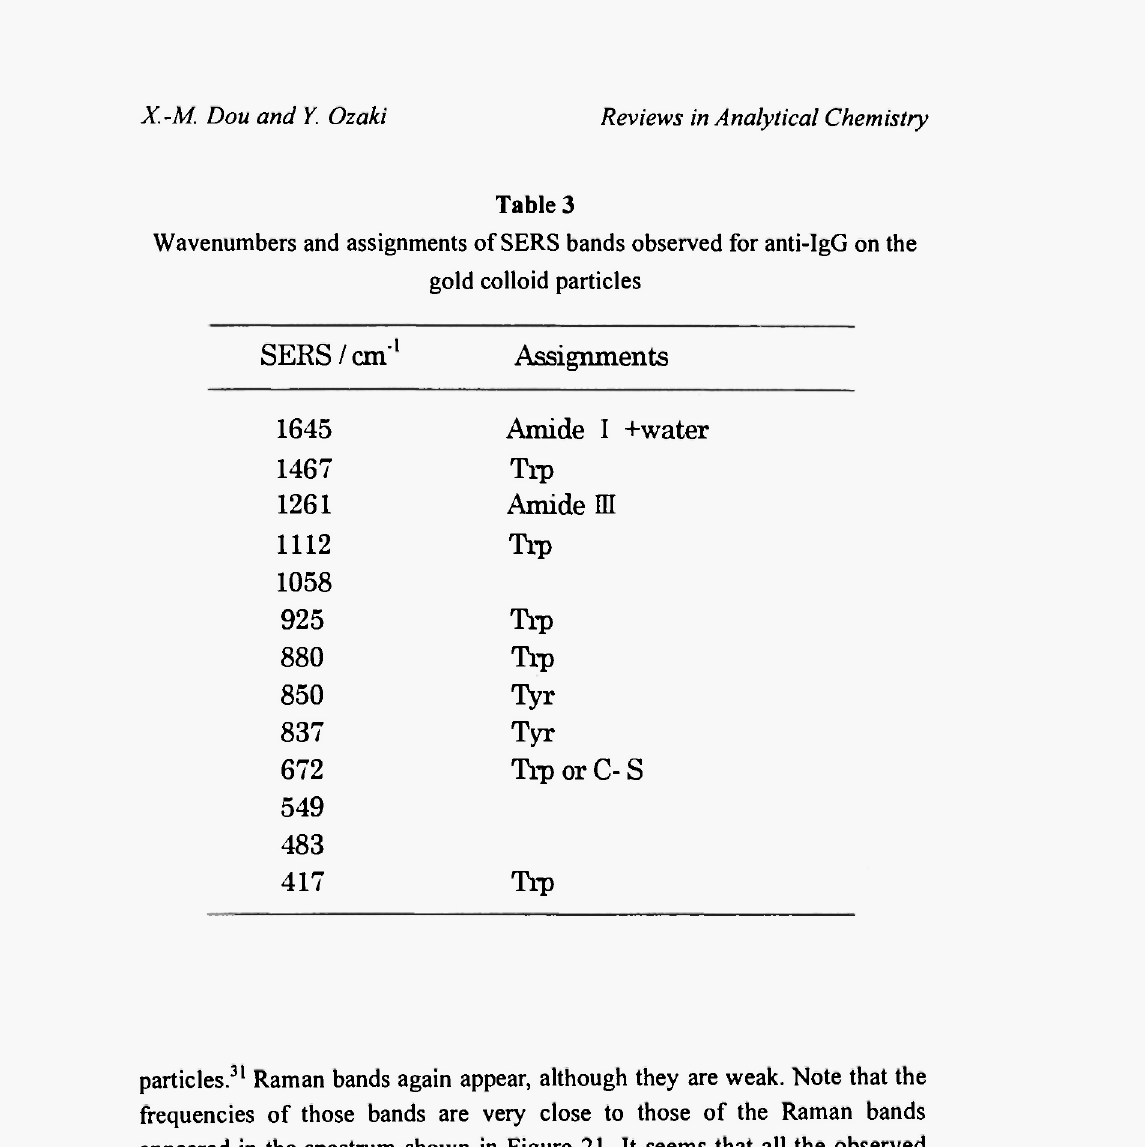
Wavenumbers and assignments of SERS bands observed for anti-IgG on the gold colloid